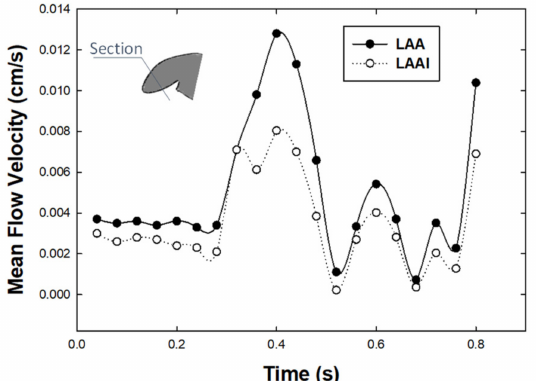
Figure 7. Mean flow velocity over one cardiac cycle at the tip of LAAI and in a cross-section of LAA (see